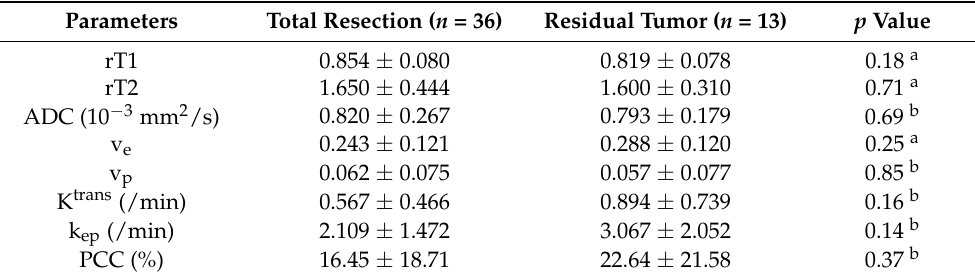
Table 5. MRI parameters and histologic percentage of collagen content of total resection and resid- ual